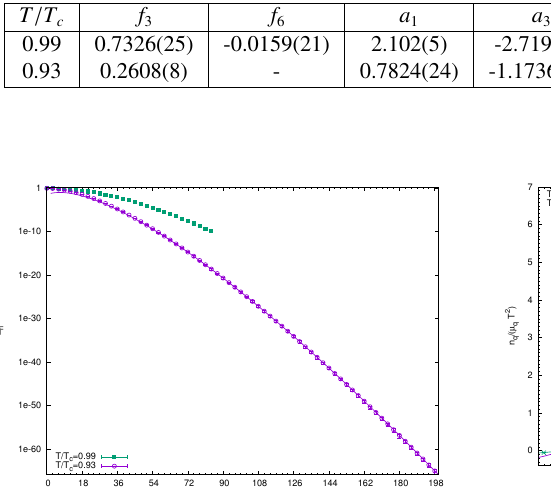
Table 1. Results of fitting data for n qI / T 3 in the confinement phase to the functions (9) and (10). The 6th column with χ 2 and N dof demonstrates the results for the fit